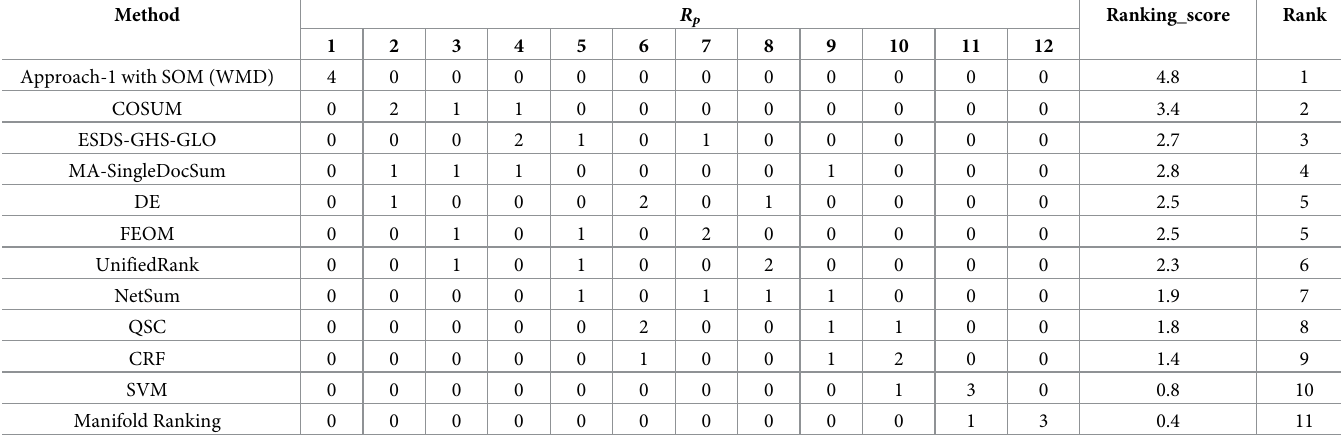
Table 11. Ranking of different